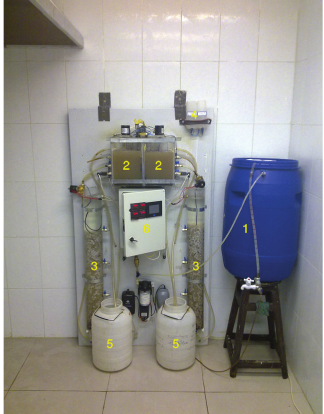
Figure 3: Units of reaction pilot: 1—feed tank, 2—aeration tank (SHARON, Single reactor system for High activity Ammonium Removal Over Nitrite), 3—ANAMMOX reactor, 4—pH adjustment tanks, 5—effluent tank, 6—PLC